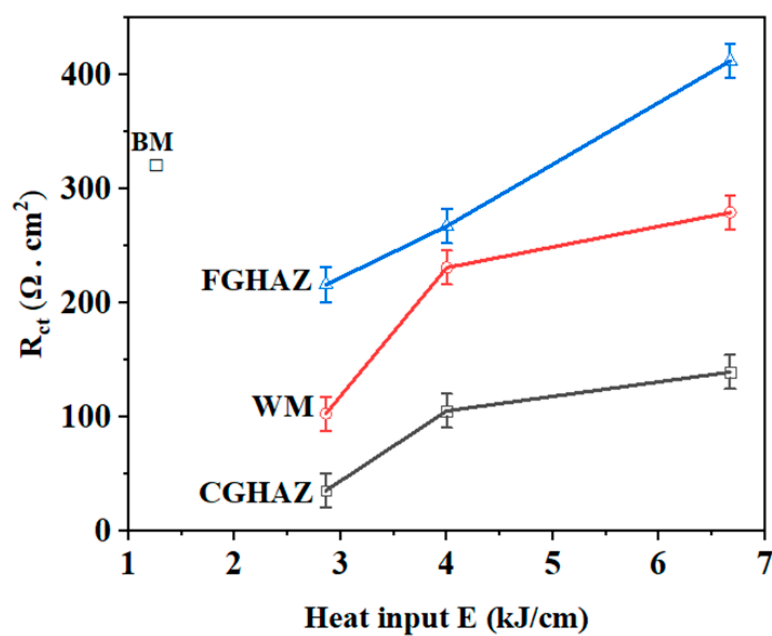
Figure 13. Fitting results of R ct extracted from impedance spectrum curves of different samples. Table 4. The fitted values of EIS for different samples under immersion for 0 h.